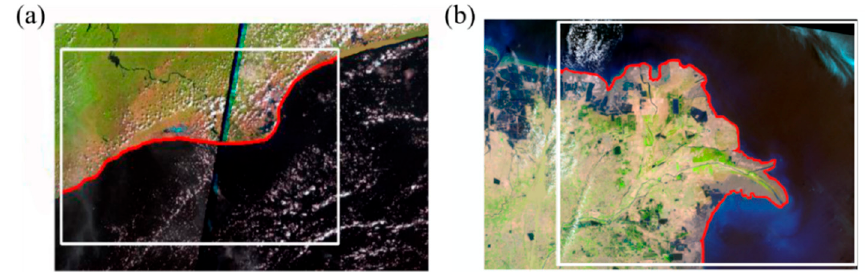
Figure 2. Extraction of the shoreline of ( a ) the Volta River Delta and ( b ) the Yellow River Delta. The red line is the extracted shoreline and the white polygon is the intersected polygon.